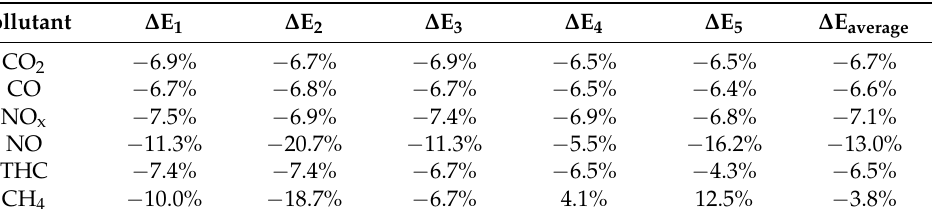
Table 8. Relative percentage difference between the pollutant emissions as calculated by the nor- mative method and the corrected method.